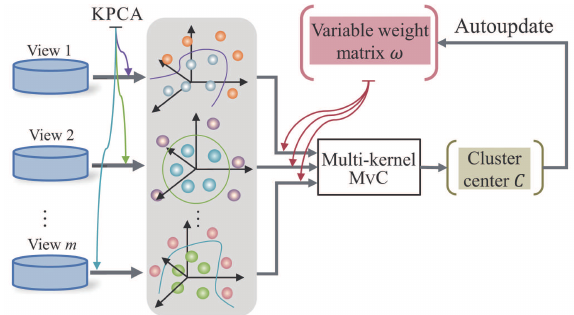
Fig. 5 The flow chart of auto-weighted multi-kernel